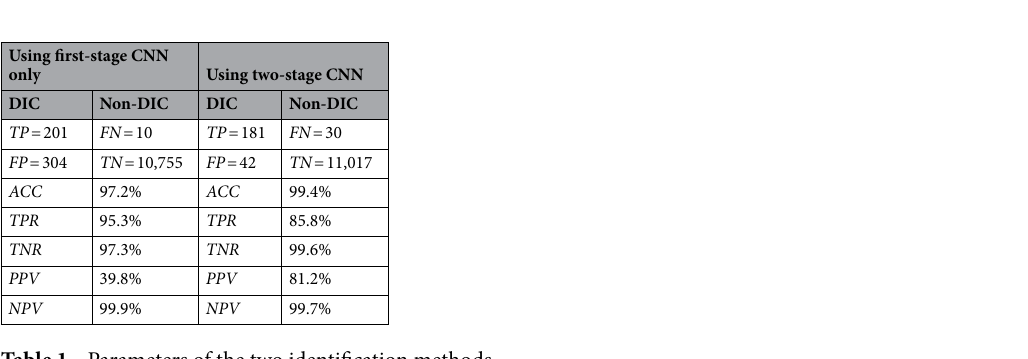
Table 1. Parameters of the two identification